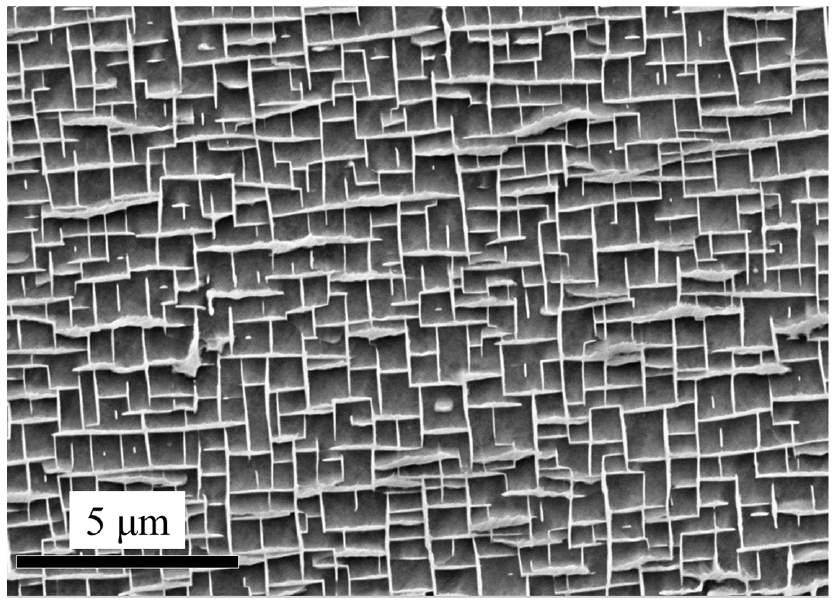
Figure 1. Microstructure of the core section from which the specimens S01 − N, S03 − N and S10 − N were cut.